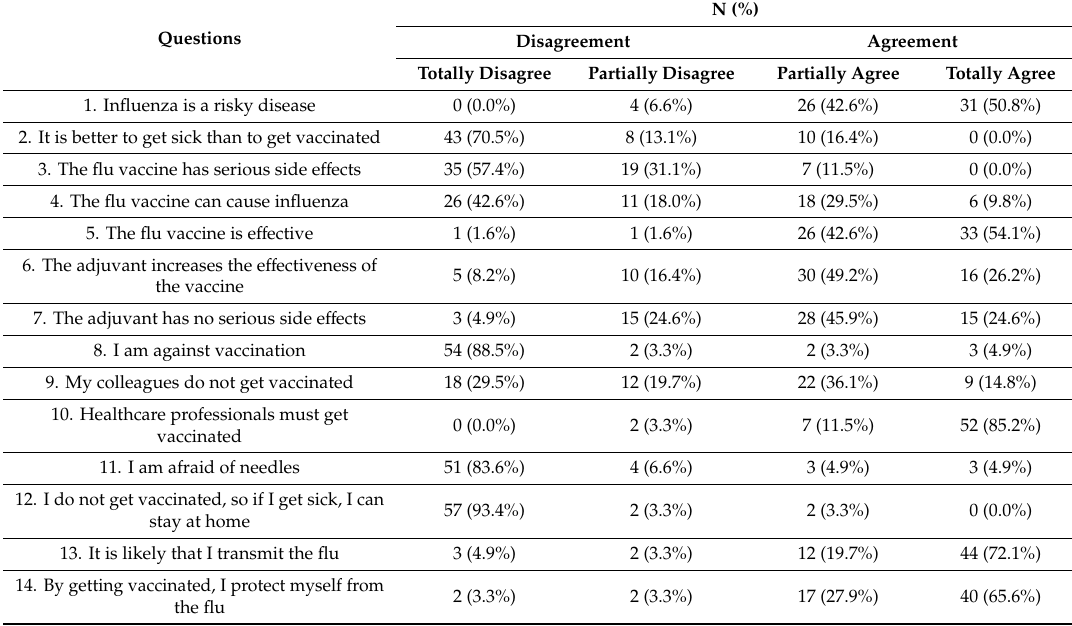
Table 2. Sample’s answers to Section A of the questionnaire (number and